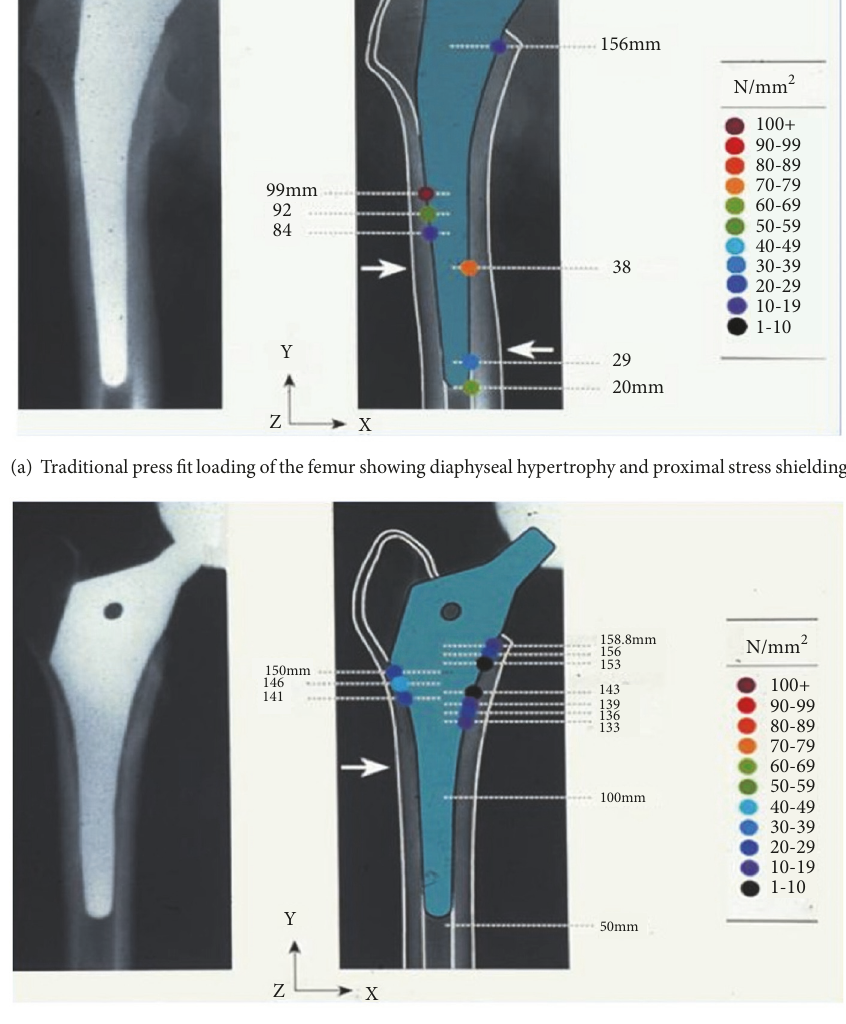
Figure 3: 2-year stress distribution within the femur as a consequence of stem